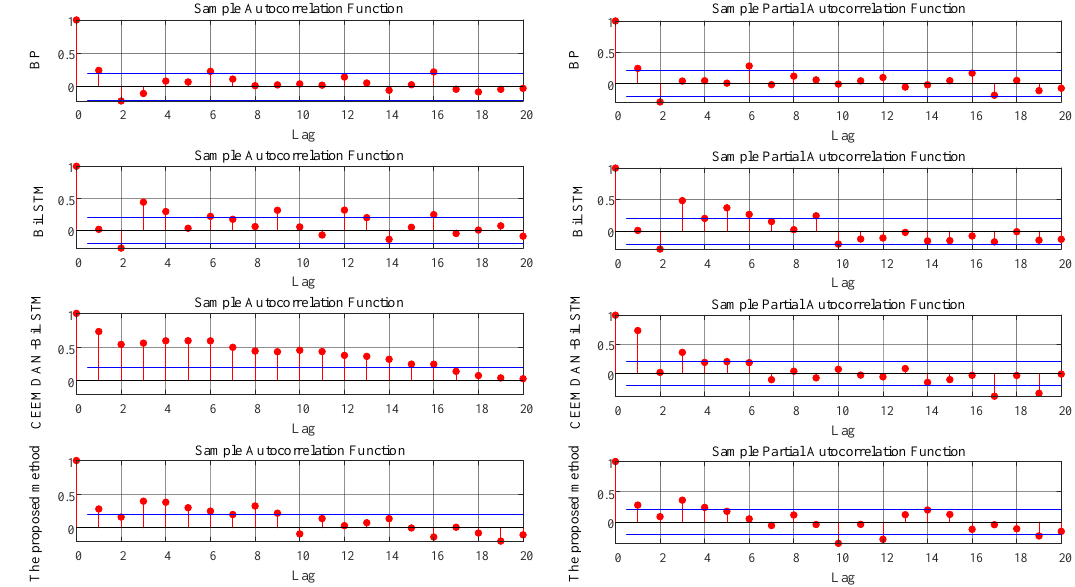
Figure 8. The ACF and PACF plots of the final residuals for changeable days.